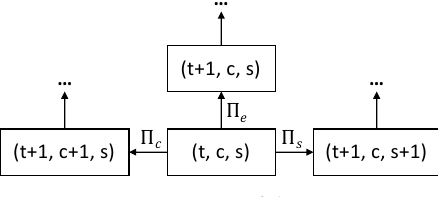
Figure 3. Diagram of the